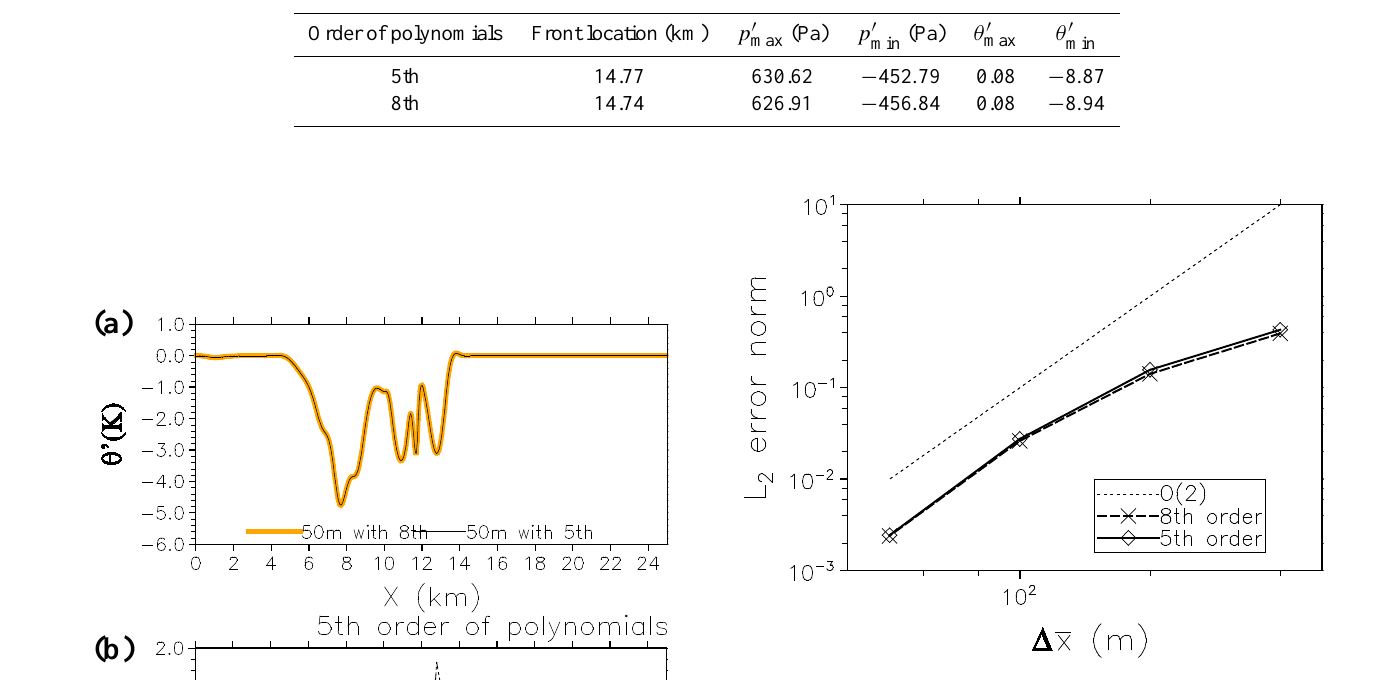
Figure 8. Self-convergence test for the density current test; relative FIG. 8. Self-convergence test for the density current test; Relative L2 error norms of the 2 L2 error norms of the potential temperature perturbation θ (cid:48) as func- potential temperature perturbation θ′ as functions of the space resolution x ∆ are shown. The 3 tions of the space resolution (cid:49) ¯ x are shown. The reference solutions reference solutions for these computations were made with 25x ∆ = m, 64z ∆ = m, and 4 for these computations were made with (cid:49) ¯ x = 25m, (cid:49) ¯ z = 64m, and (cid:49)t = 0 . 1s. The dotted line represents second-order conver- 0.1t ∆ =